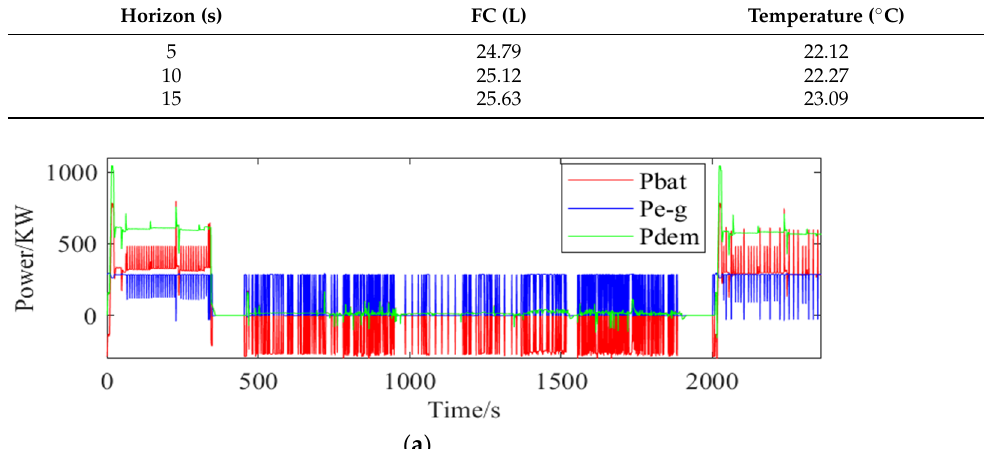
Figure 11. SOC profiles with different prediction horizon lengths. ( a ) SOC profiles with different predicted horizon lengths under driving cycle A. ( b ) SOC profiles with different predicted horizon lengths under driving cycle B. Table 3. Results of PMP-MPC with three prediction horizons in driving cycle B. Table 2. Results of PMP-MPC with three prediction horizons in driving cycle A.